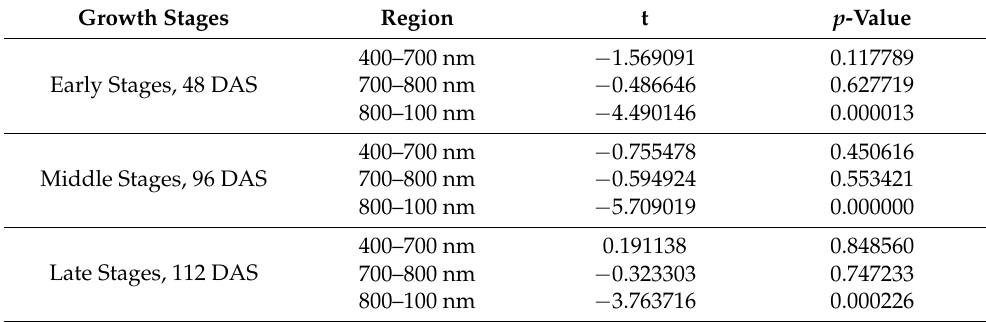
Table 2. Paired sample t -test results between the top 10% and bottom 10% yield